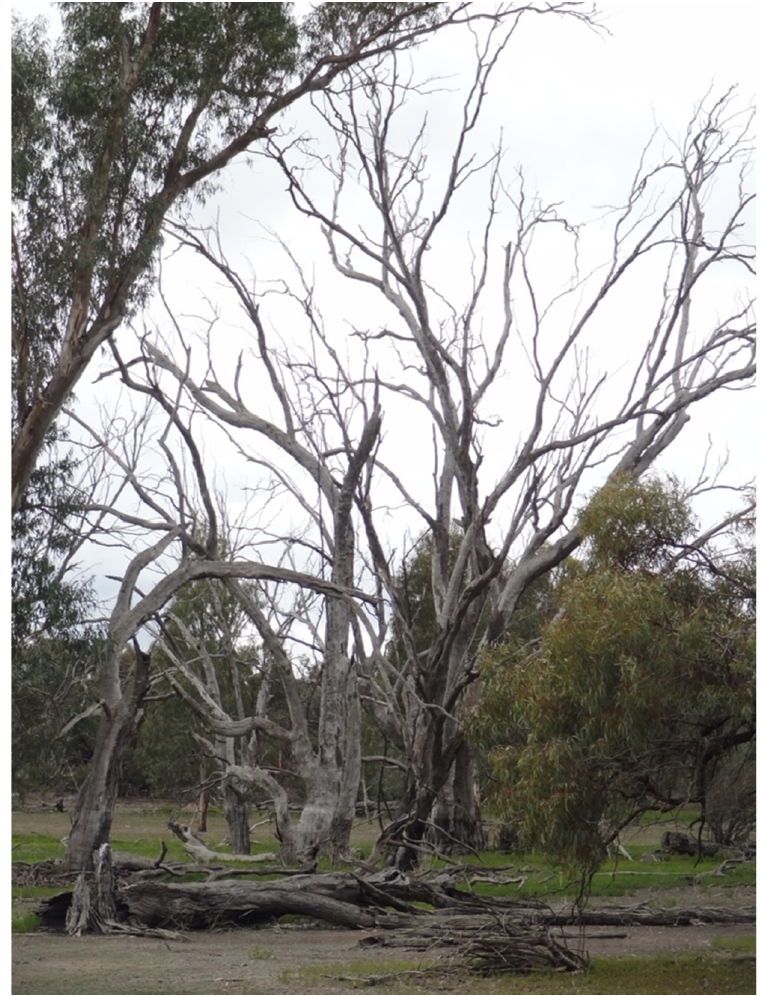
Figure 7. Native tree dieback in Hattah Kulkyne National Park, in the Murray Darling Basin, southeastern Australia (Photo: D. Fernando 2012).